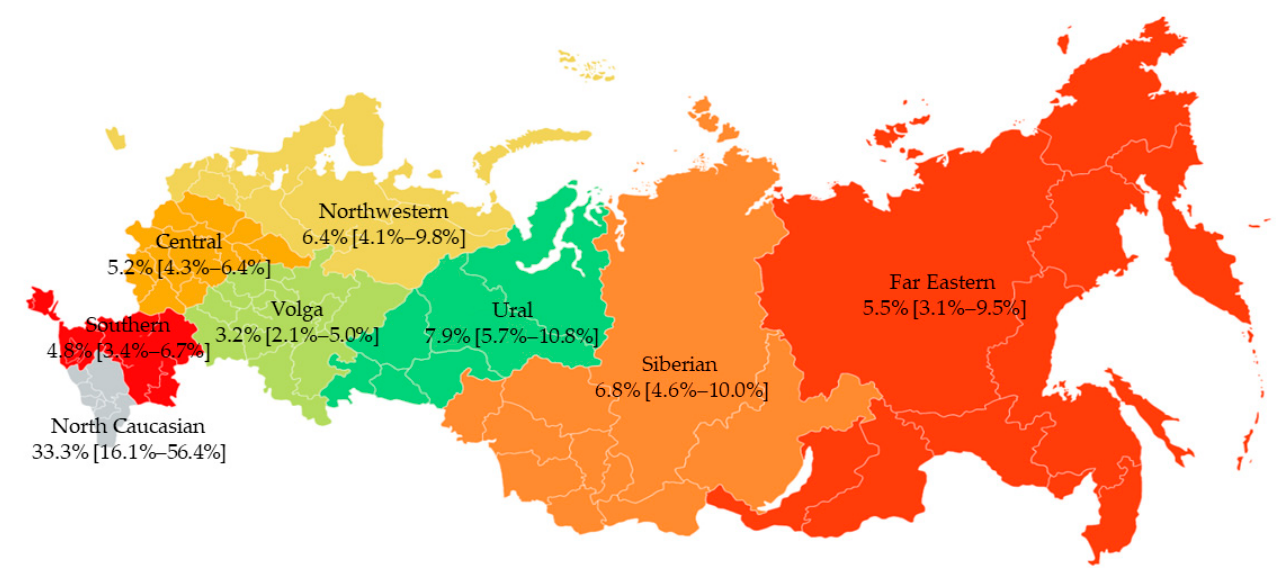
Figure 3. Prevalence of SDRMs in FDs of Russia in the 2006–2022 sampling years. The range of the 95% confidence interval is enclosed in square